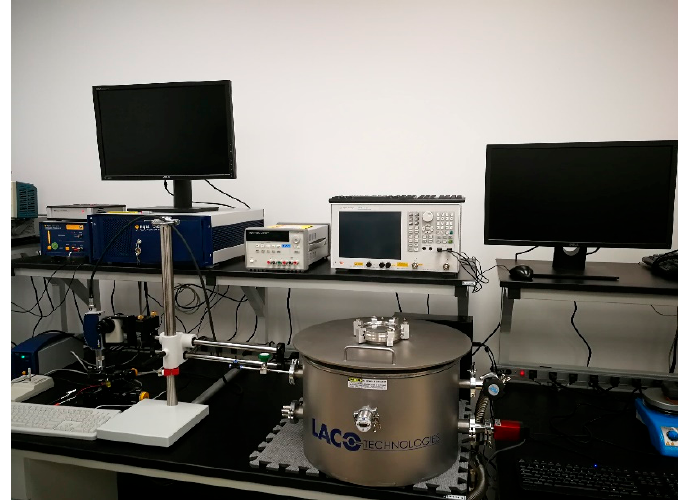
Figure 3. Photograph of the test setup used for the measurements showing the gas chamber, the multimeter, and the computer for data acquisition.